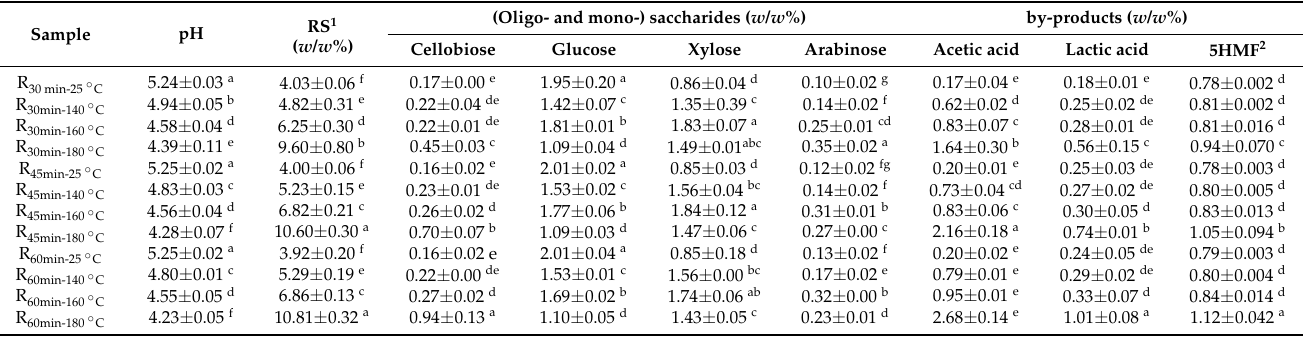
Table 1. The chemical component, yield, and pH of the liquid sample in the first stage of different HTE conditions. Average ± s.d. Values in a column sharing an alphabet are not significantly different ( p <